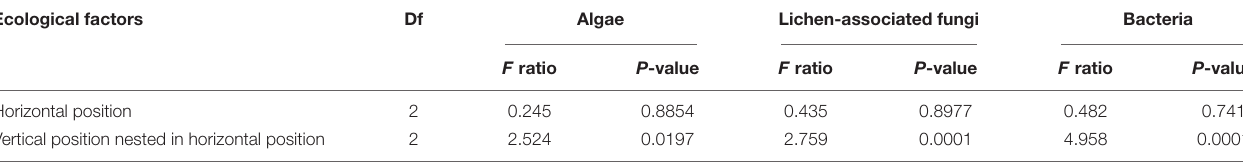
TABLE 2 | Permutational multivariate analysis of variance (PERMANOVA) with nested design according to the horizontal and vertical positions of Cladonia squamosa. Ecological factors Df Algae Lichen-associated fungi Bacteria